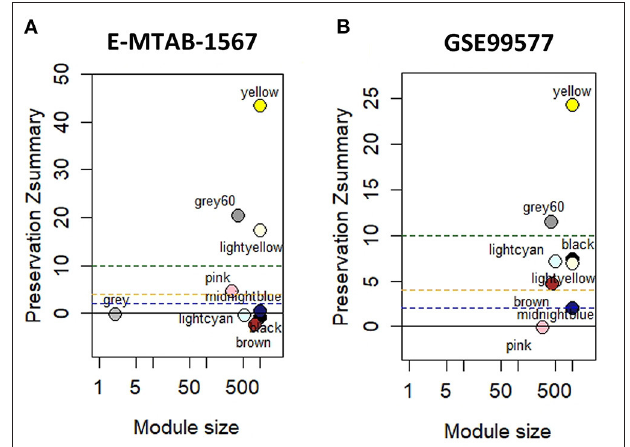
FIGURE 2 | Module preservation analysis with hippocampal datasets. (A) Module preservation analysis of GSE49849 vs. E-MTAB-1567. (B) Module preservation analysis of GSE49849 vs. GSE99577.